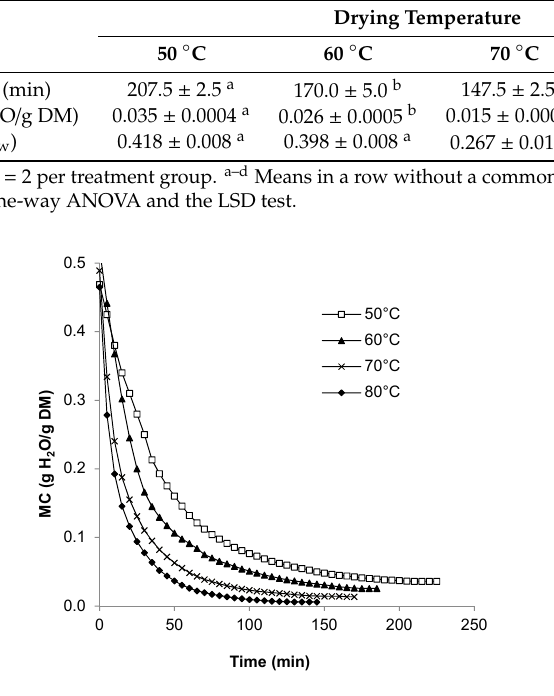
Table 2. Time taken for dried pumpkin seeds to attain equilibrium, equilibrium moisture content and water activity values of dried seeds, at a fixed velocity of 2.87 m / s.